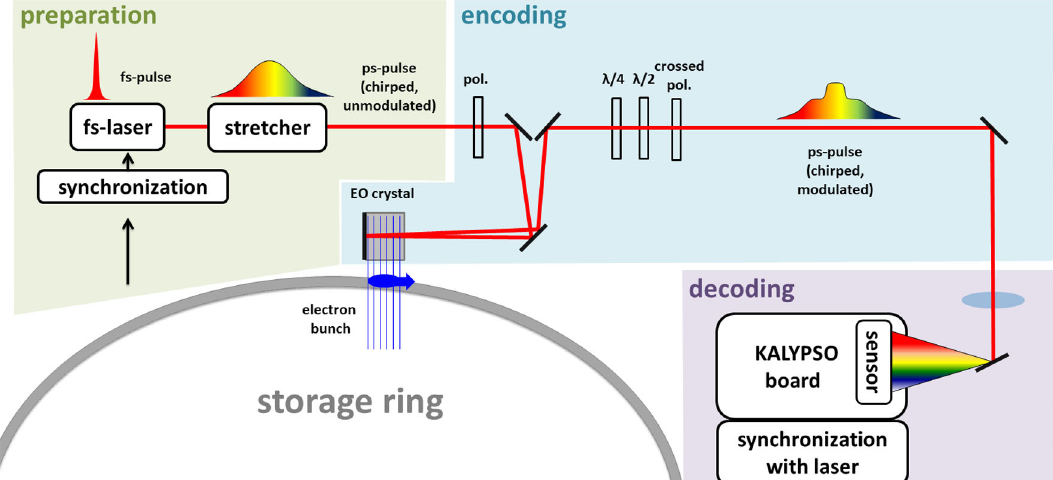
FIG. 1. The setup to measure longitudinal charge density profiles of electron bunches at KARA is shown: The radiation is prepared by providing linearly chirped laser pulses synchronized to the bunch repetition rate, then the bunch profile is encoded onto the laser pulse in an electro-optical crystal and finally, the decoding of the bunch profile is performed using an ultra-fast line array (KALYPSO). For illustration, the laser beam path angles at the EO-crystal and mirrors are exaggerated and not to